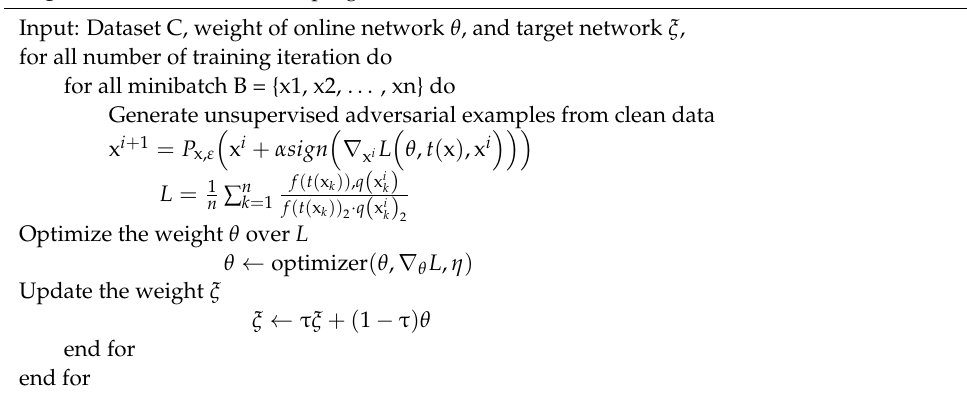
Algorithm 1 summarizes the progress of